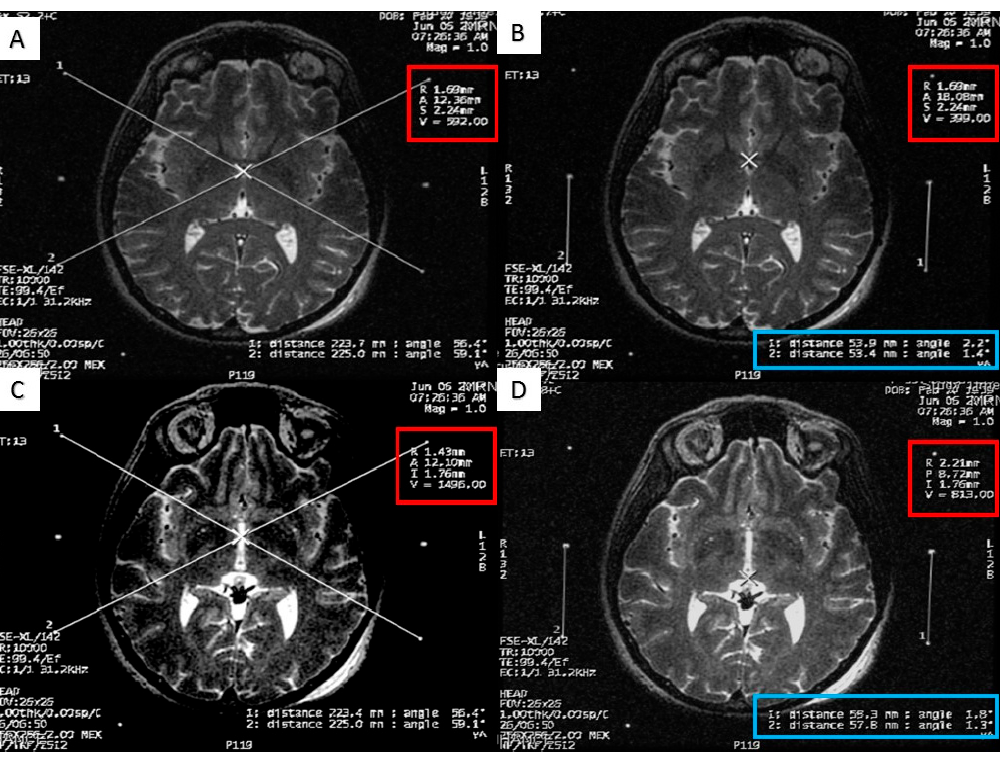
Figure 3. Calculating the anterior commissure (AC) and posterior commissure (PC) coordinates using the magnetic resonance scanner console. ( A ) Two diagonal lines intersecting at the center of the frame at the AC level with the magnetic resonance imaging (MRI) coordinates of the center of the frame shown inside the red square; ( B ) a crosshair at the posterior margin of the AC, with the MRI coordinates of the AC shown inside the red square. Two lines are drawn between the middle and the lower fiducials on both sides of the frame and their lengths (in the blue rectangle) are used to calculate the Z coordinate of the AC; ( C ) two diagonal lines intersecting at the center of the frame at the PC level with the MRI coordinates of the center of the frame shown inside the red square; ( D ) a crosshair at the anterior margin of the PC, with the MRI coordinates of the PC shown inside the red square. Two lines are drawn between the middle and the lower fiducials on both sides of the frame and their lengths (in the blue rectangle) are used to calculate the Z coordinates of the PC.